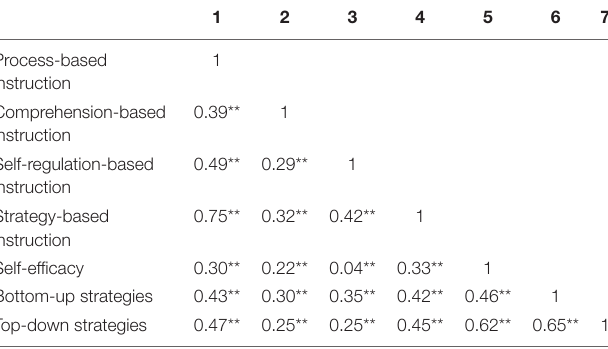
TABLE 2 | Reliability estimates of the questionnaires in the main study. Subscale No. of items Cronbach α Mean SD